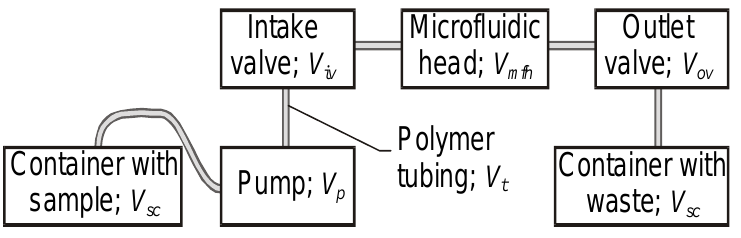
Figure 2. The setup for control of the volume and movement of